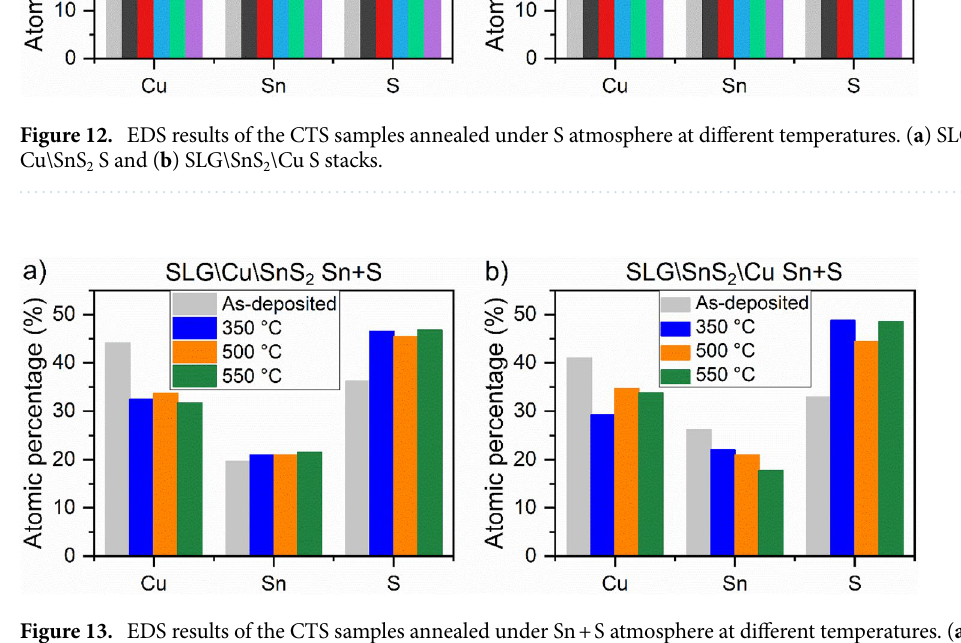
Figure 13. EDS results of the CTS samples annealed under Sn + S atmosphere at different temperatures. ( a )